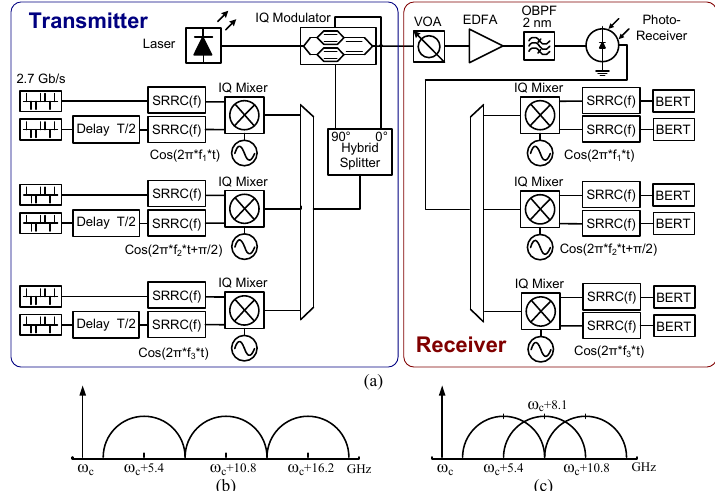
Figure 1. ( a ) Direct Detection (DD) electro-optical scheme compatible with subcarrier multiplexing (SCM)/single side band (SSB) and orthogonal subcarrier multiplexing (OSCM)/SSB transmission based on optical IQ modulator and pre-amplified optical receiver; ( b ) example of transmitted optical spectrum for the case of SCM/SSB consisting of three 2.7 Gbaud quadrature phase shift keying (QPSK) subchannels; ( c ) example of transmitted optical spectrum for the case of OSCM/SSB consisting of three orthogonally overlapping 2.7 Gbaud QPSK subchannels.